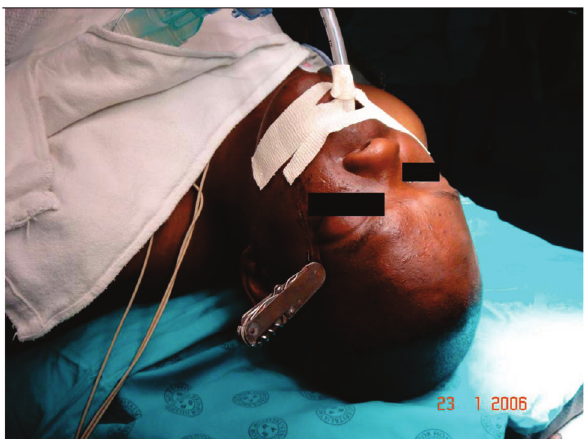
Figure 1 . Photograph showing knife position, entering left orbit at superior temporal aspect.